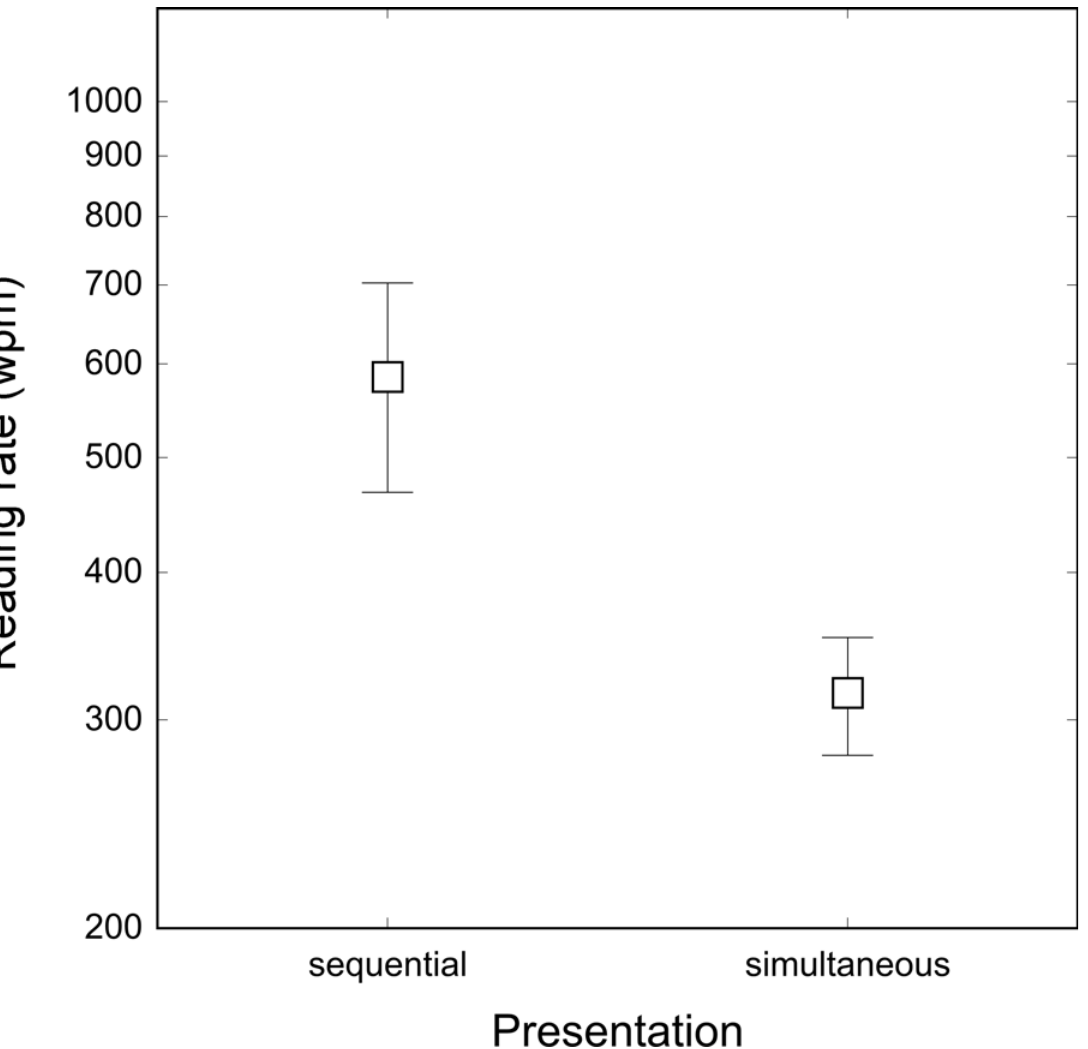
Fig 4. Reading rate (wpm) for words in the sequential and simultaneous presentation conditions. No mask was used. Bars represent standard